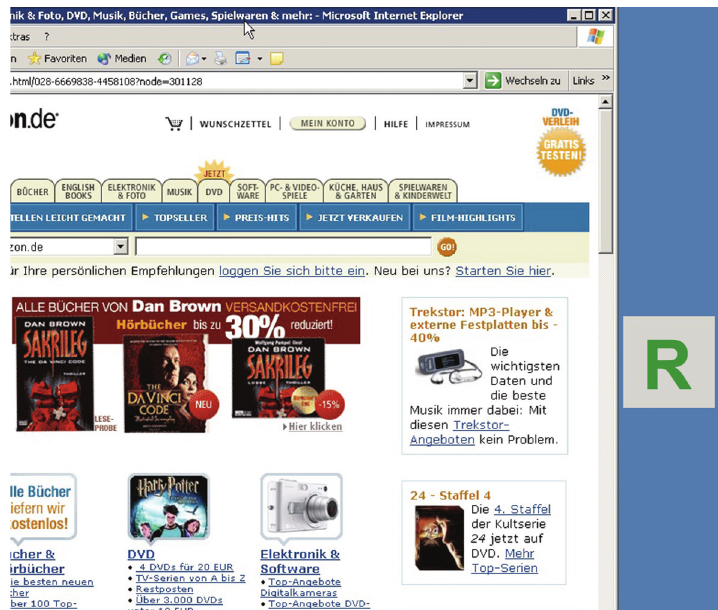
Figure 1: Screenshot of the materials used. On the left hand side, the browser window displaying on of the four bookstores is shown. On the right hand side, the window presenting the secondary task can be